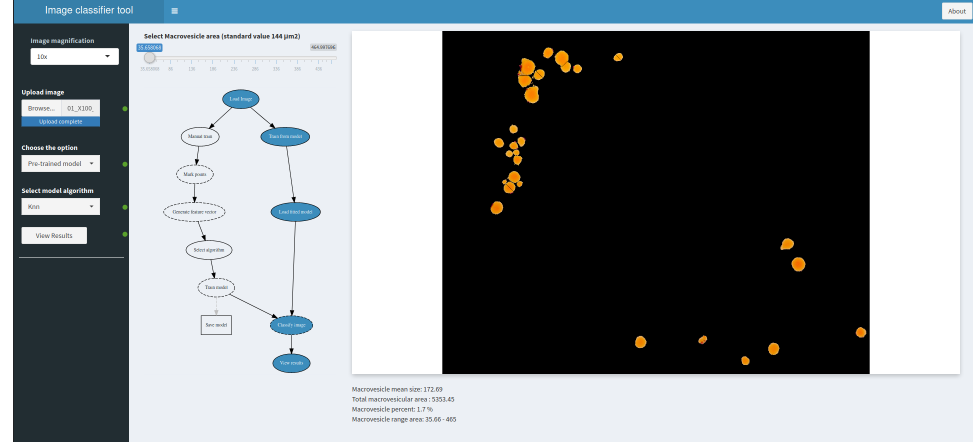
Figure 7. Result of image classification and quantification of fatty